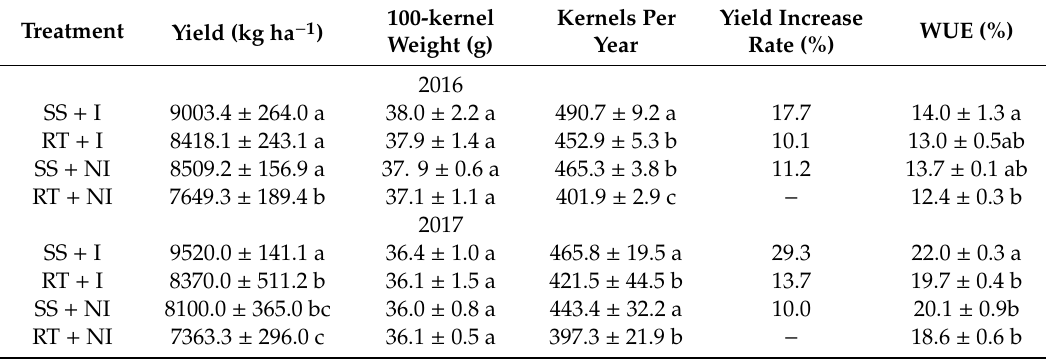
Table 8. E ff ects of di ff erent tillage methods on grain